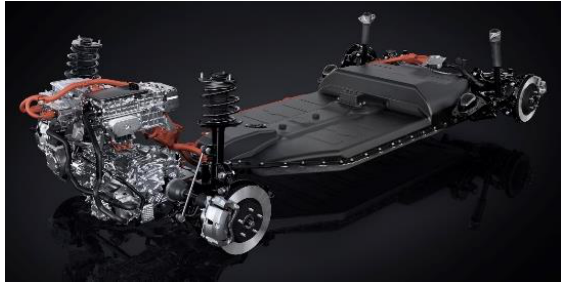
Fig. 13. Arrangement of the components of the electric driveline (Lexus UX) [8]